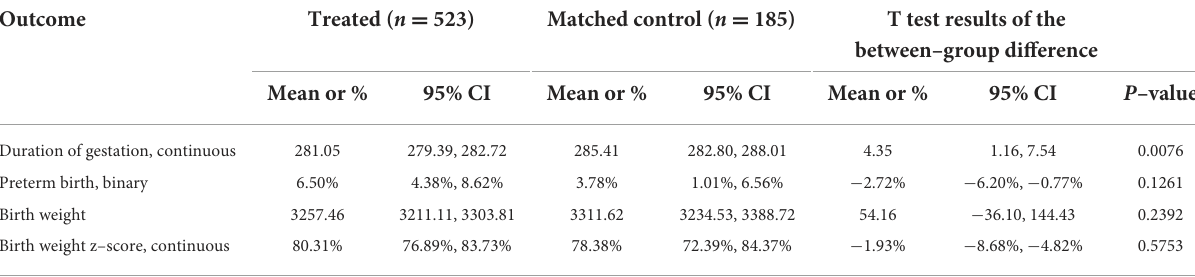
TABLE 1 Neonatal outcomes between the treated and matched control groups after propensity score matching in the intertemporal group. Outcome Treated ( n = 523) Matched control ( n = 185) T test results of the